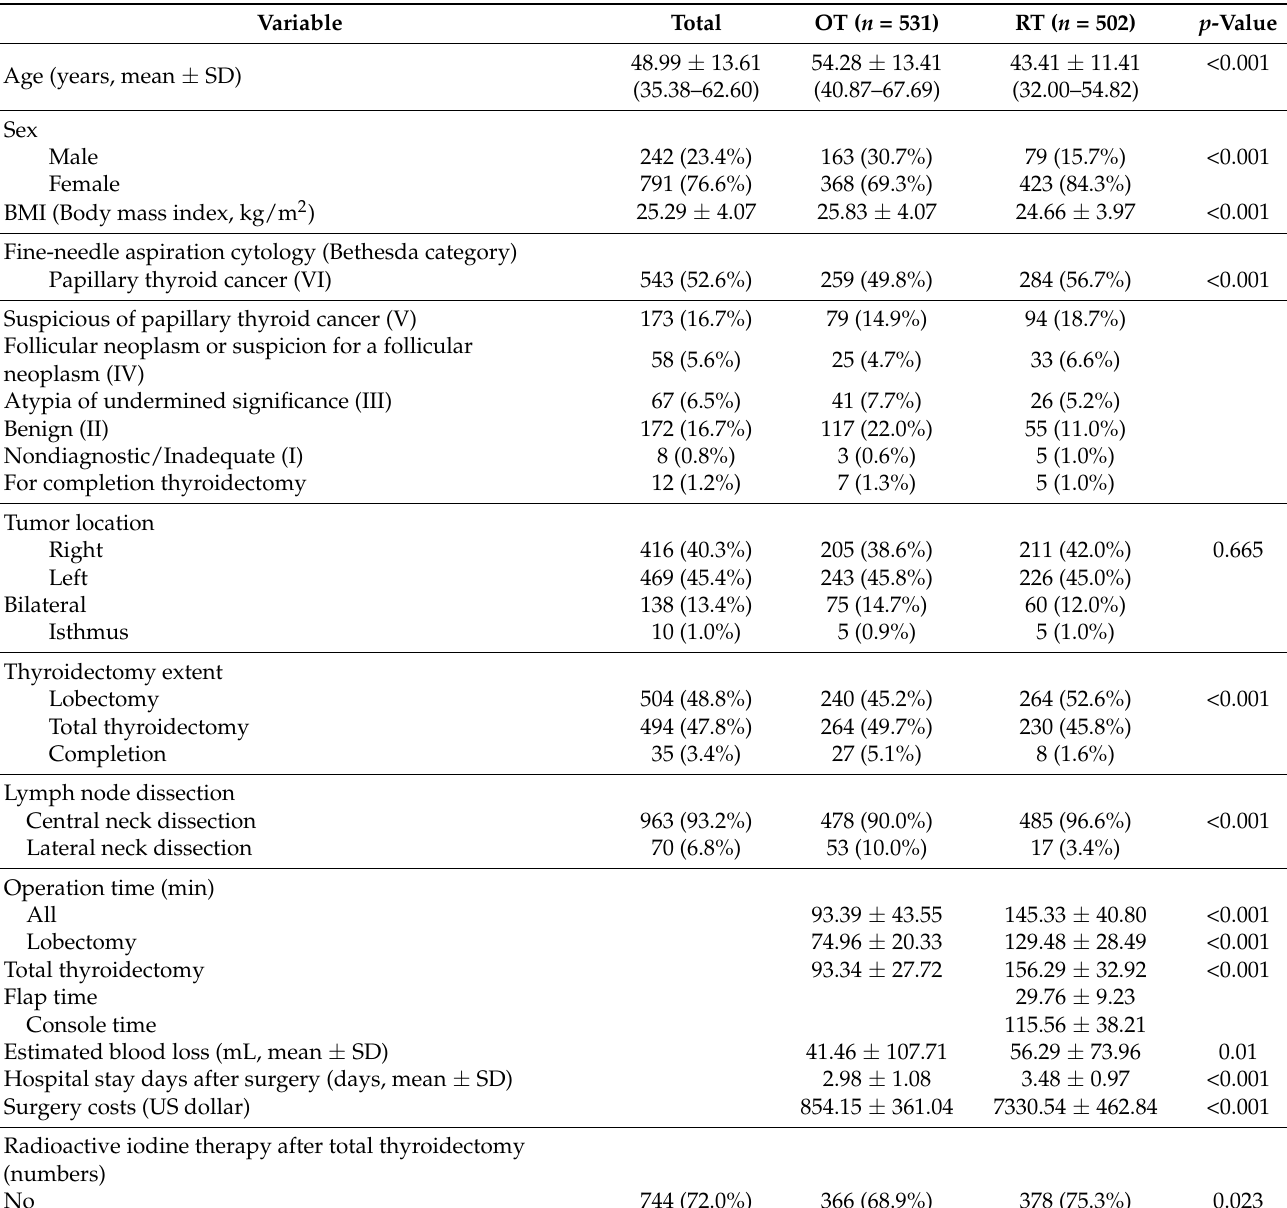
Table 1. Clinical characteristics and pathologic variables of the patients included in this